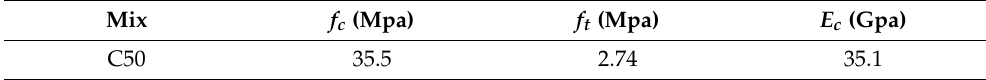
Table 2. Material properties of C50.